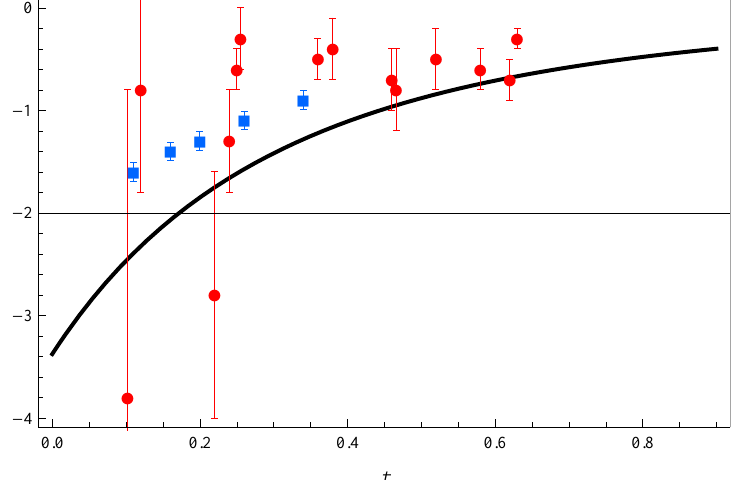
D fit ( t ) for the region of small t . The experimental data Figure 2. The preliminary upper estimation of 5 4 on the nucleon D -term form factor: the blue squares from the Jefferson Lab [14], the red bullets from the lattice quantum chromodynamics (QCD)